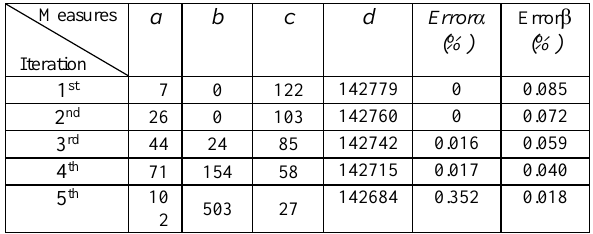
Table 3. The values of accuracy assessment